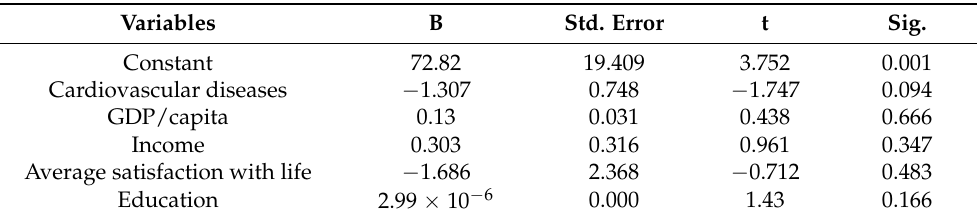
Table 1. Regression analysis.